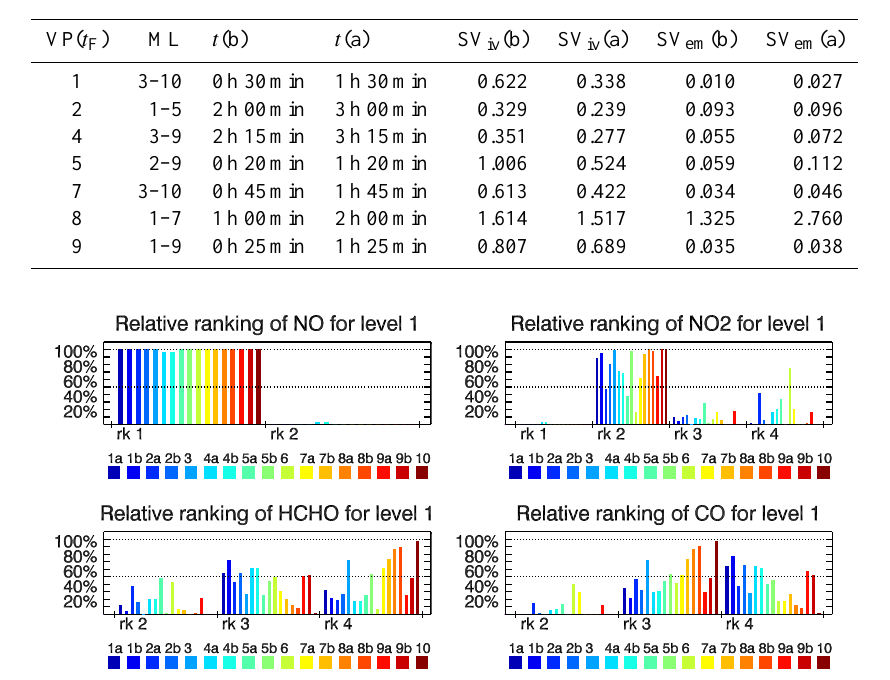
Table 4. Singular values (SV) with respect to initial values (iv) and emissions (em). VP( t F ) denotes the considered final profile (numbers according to Table 1) and ML the associated model levels. Only simulations with a shared final profile VP( t F ) are listed; “a” marks the simulation with the longer simulation interval and “b” the simulation with the shorter simulation interval. t (a) and t (b) are the associated simulation lengths.